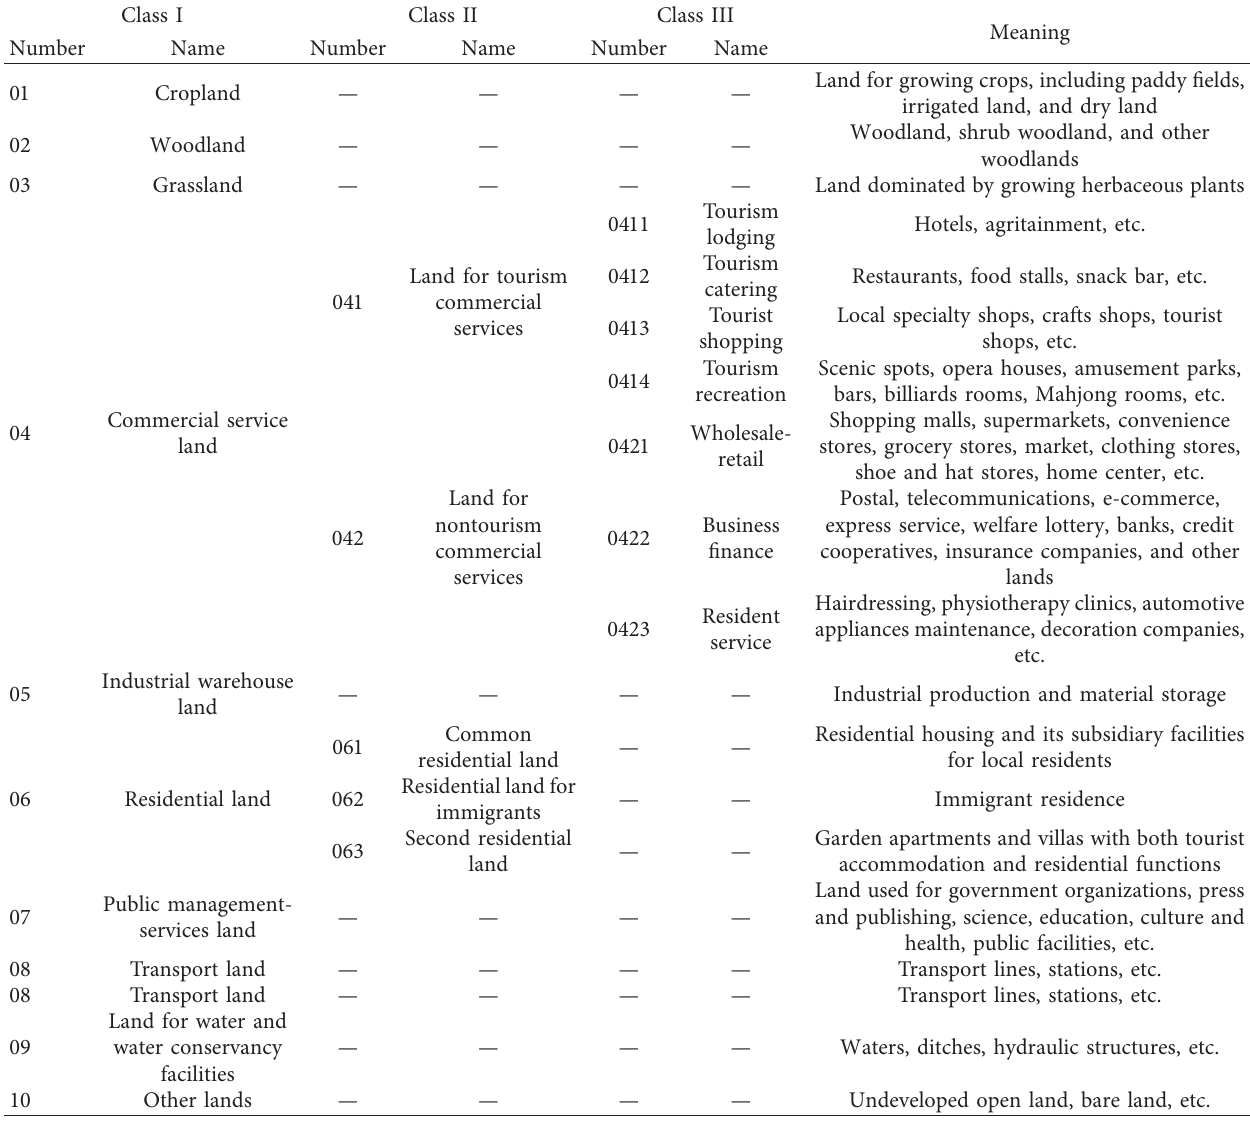
Table 1: Classification system for land use in tourist